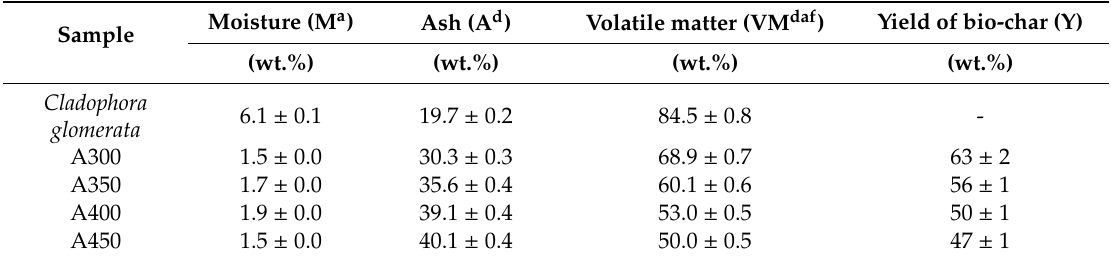
Table 1. Proximate analysis of biochars (N =